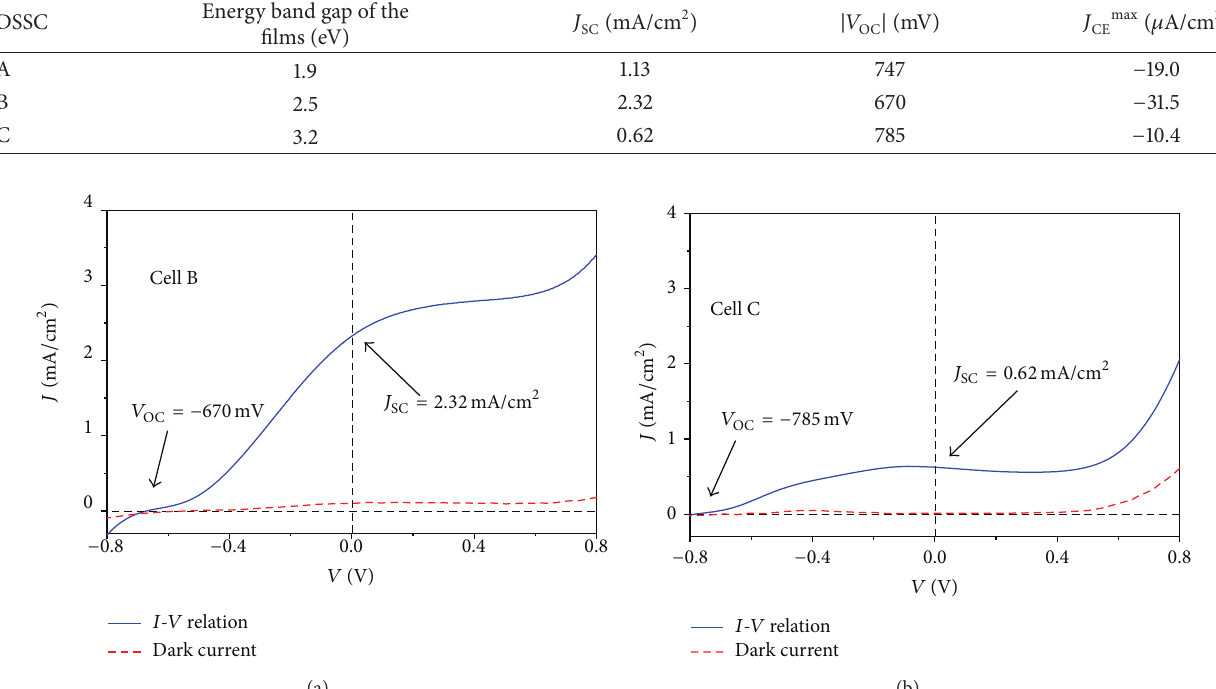
Table 2: Short-circuit current density, open-circuit voltage, and maximum dark current for cells A, B, and C. The maximum dark current . was taken for each respective 𝑉 OC